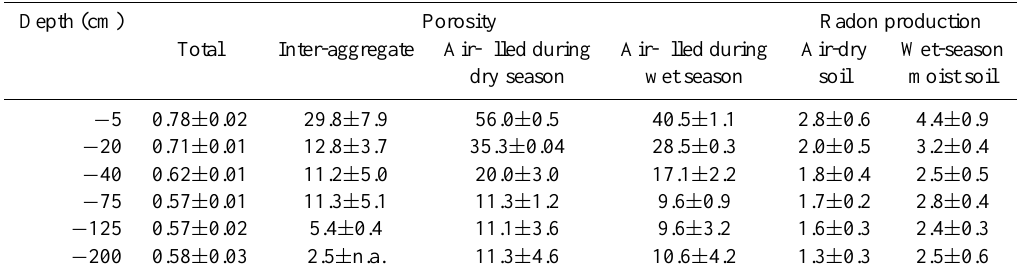
Table 1. Mean ( ± SE) soil total porosity (cm 3 cm − 3 , n =3), its inter-aggregate ( n =2) and air-filled fractions (% of total porosity, n =3)